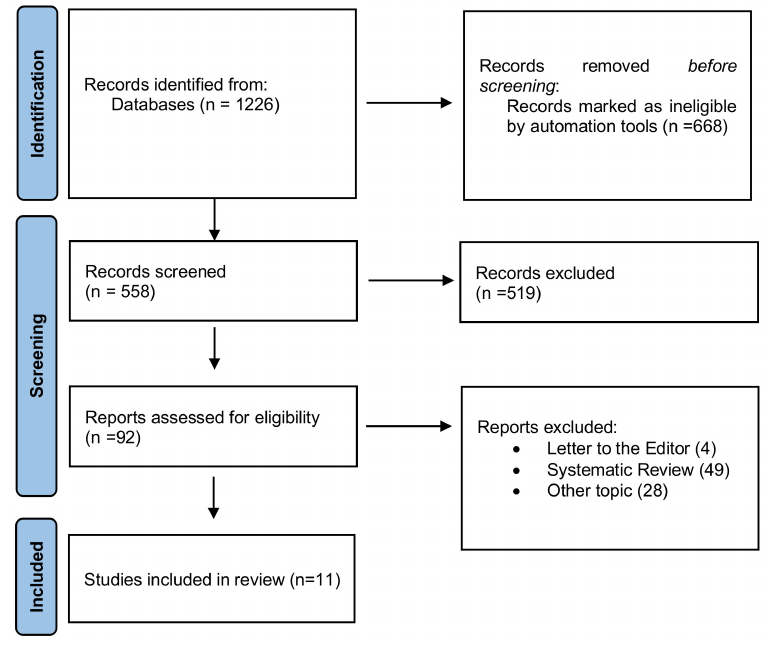
Figure 1. PRISMA 2020 flow